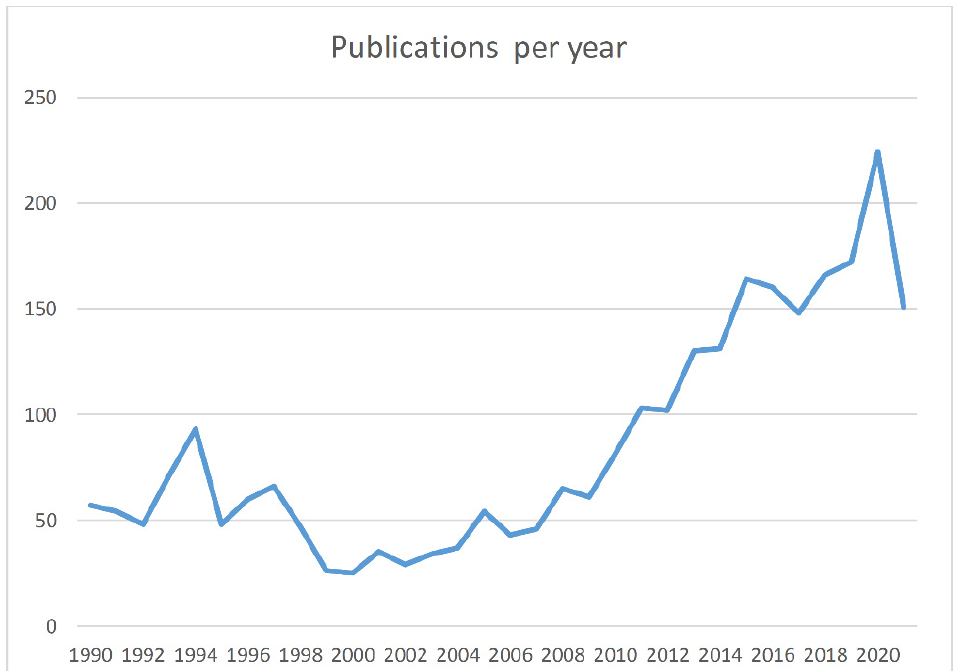
Figure 1. Flowchart of the search strategy according to the PRISMA framework.